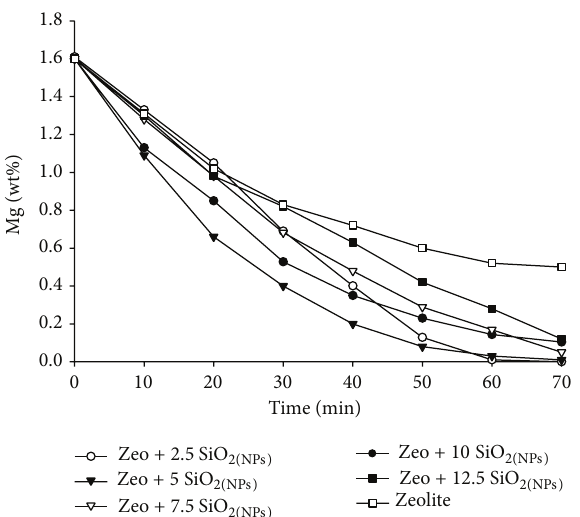
Figure 5: Mg removal from the alloy as a function of injection time using zeolite and zeolite with different percentages of SiO 2(